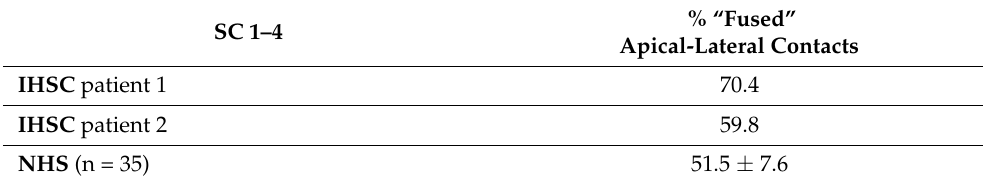
Table 3. Increased presence of fused TJ remnants in the SC of IHSC. TJ-derived fusions within the apical-lateral contacts of corneocytes were counted in the first four layers of SC. At least 100 apical- lateral contacts were examined at high magnification on several ultrafine sections of each specimen. NHS = normal human skin.